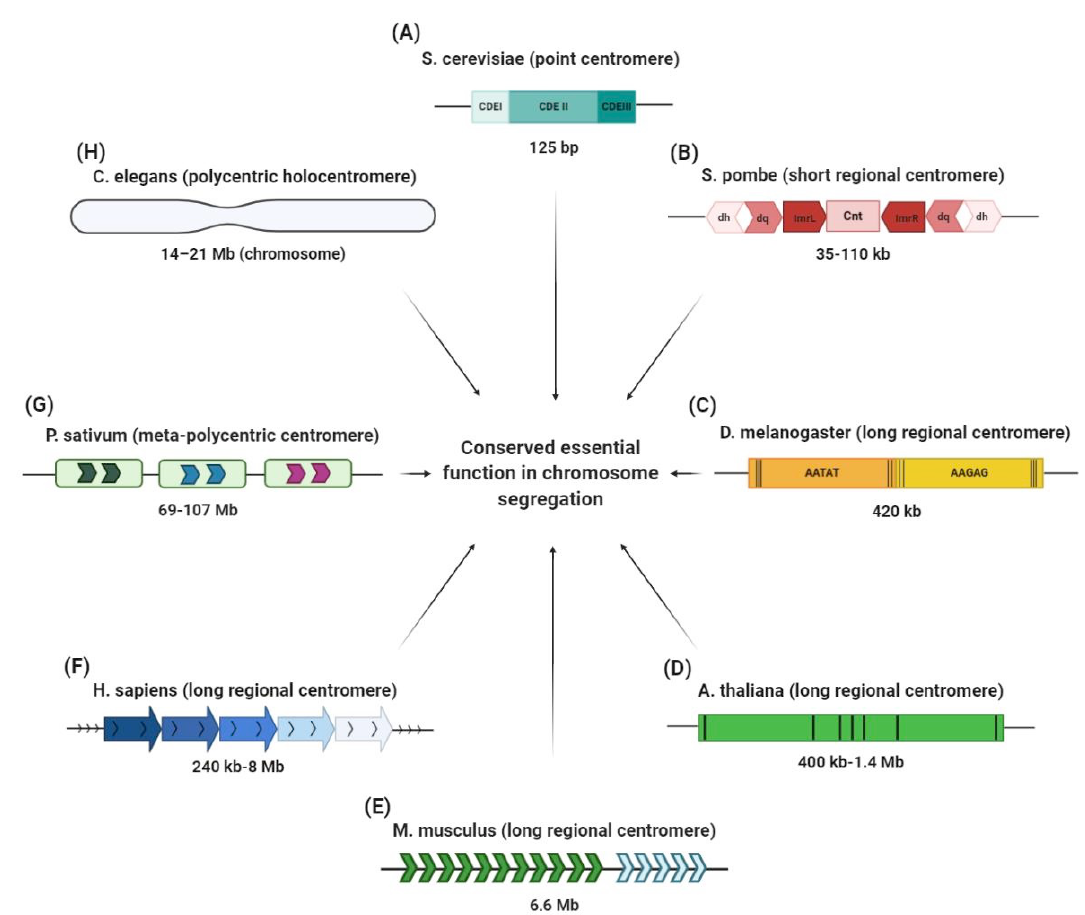
Figure 2. Centromere structures in di ff erent eukaryotes. ( A ) The S. cerevisiae point centromere is 125 bp in size and it is composed of three centromere DNA elements (CDEs): CDEI, CDEII and CDEIII. ( B ) The S. pombe centromere is made of inner (ImrL and ImrR) and outer (dg and dh) inverted repetitive sequences that flank a central unique sequence (Cnt). ( C ) The two main satellite domains (AATAT and AAGAG) of the D. melanogaster centromere are interspersed with transposable elements (black lines). ( D ) A. thaliana has a 180 bp repeat unit intermingled with retrotransposons (black lines). ( E ) The mouse centromere is made up of major satellite sequences (MaSat) of 234 bp monomers (spanning ~6 Mb; green arrows) and minor satellite sequences (MiSat) of 120 bp monomers (spanning ~600 kb; blue arrows). ( F ) Human centromeres contain tandem repeats of α -satellite 171 bp monomers organized head to tail into higher order repeats (HORs). ( G ) The meta-polycentric centromere of P. sativum is a very long centromere of 13 families of satellite DNA repeats and one family of Ty3 / gypsy retrotransposons, organized into 3–5 domains containing CenH3. ( H ) The polycentric or holocentric centromere of C. elegans covers the entire length of chromosome on which there are several points for microtubule attachment. In spite of this great diversity, all these centromeres perform faithful roles in chromosome